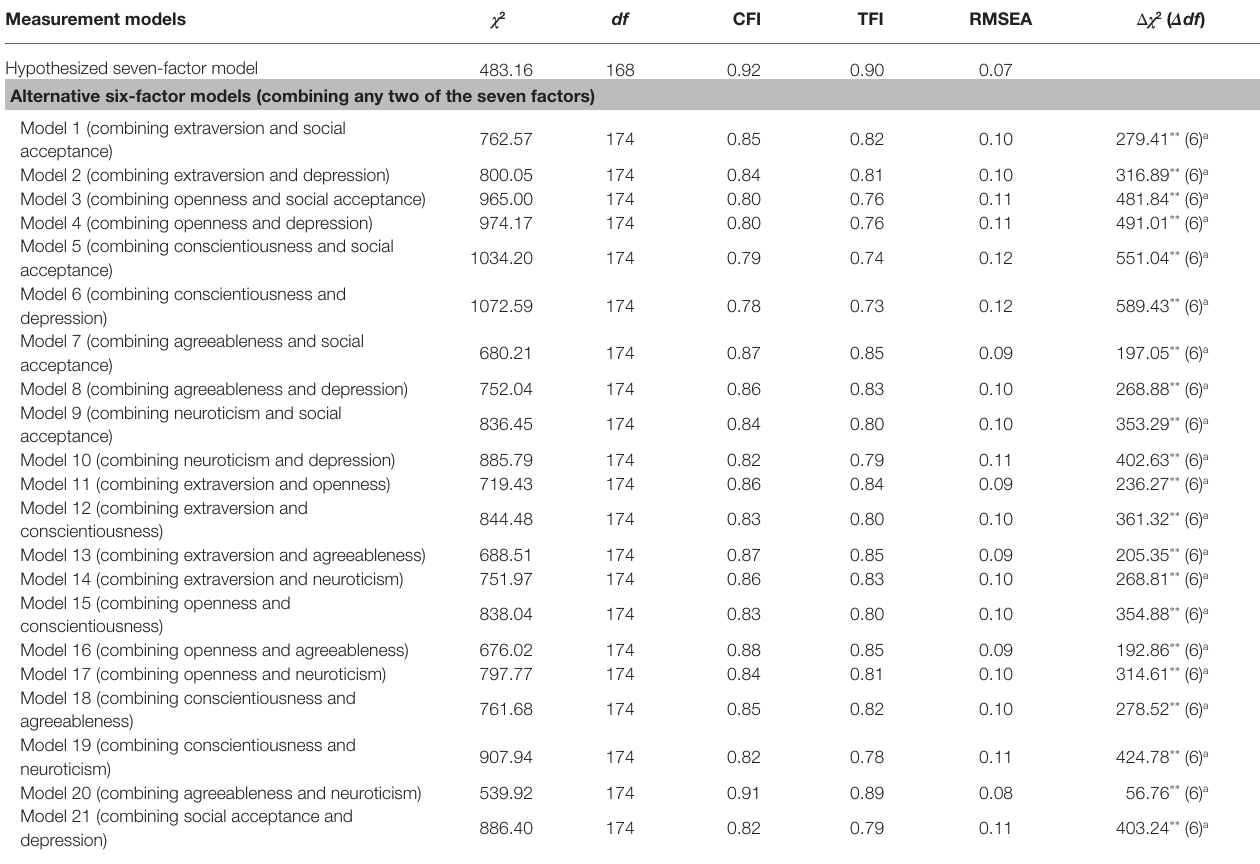
TABLE 2 | Fit indices of measurement